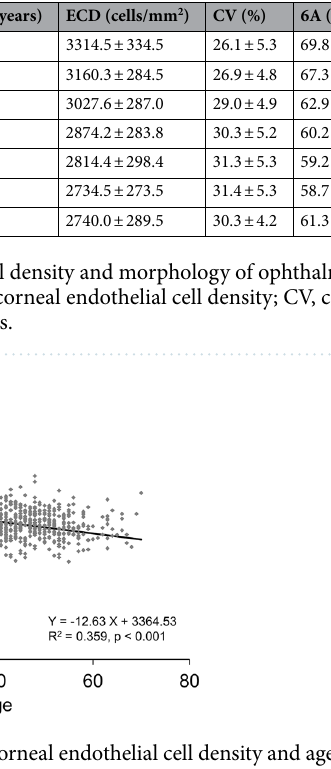
Figure 1. Association between corneal endothelial cell density and age in ophthalmologically healthy Japanese. Based on the linear regression model, a significant mild negative association between corneal endothelial cell density and age was observed (Y = − 12.63 X + 3364.53, R 2 = 0.359, p <